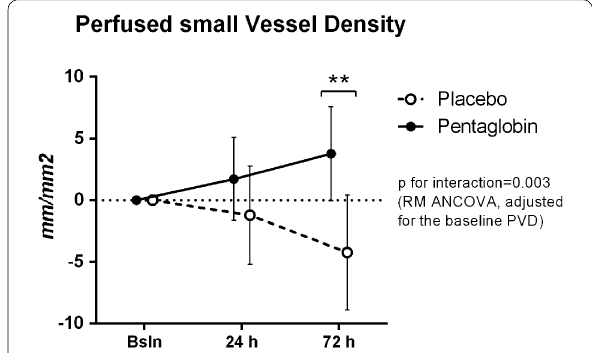
Fig. 3 Comparison of the delta values (variations from baseline) for the perfused vessel density